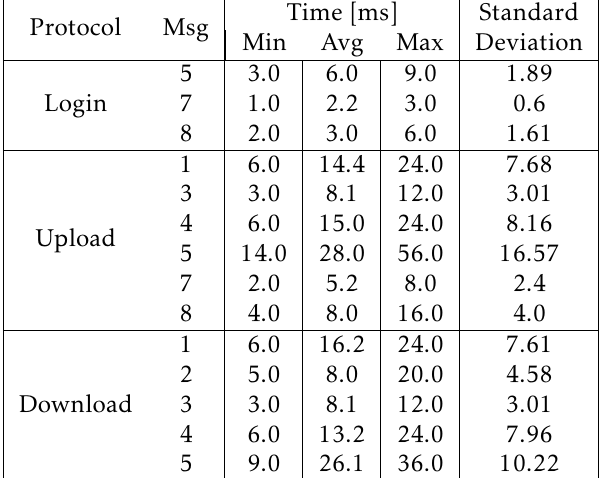
Table 1. Time required for message encryption